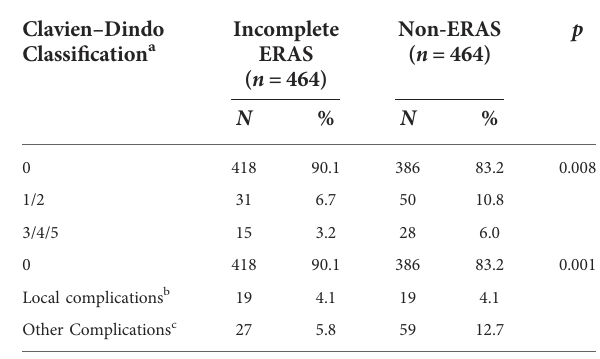
TABLE 4 The effects of incomplete ERAS on postoperative